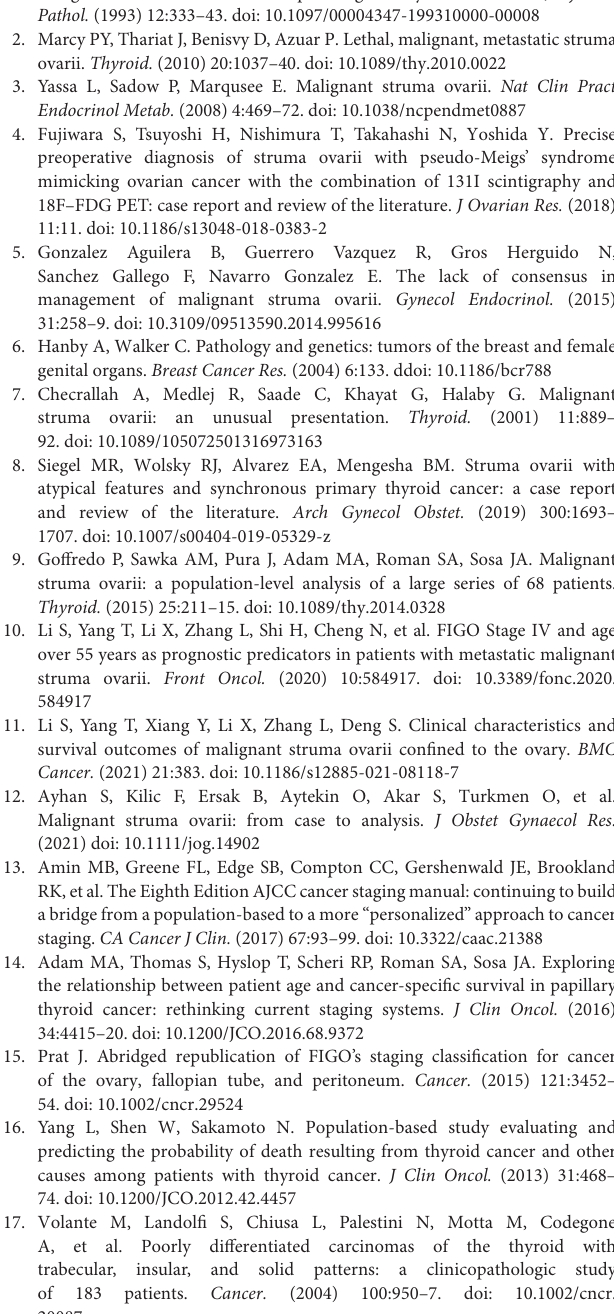
Supplementary Table 3 | The univariate and multivariate analysis of overall survival